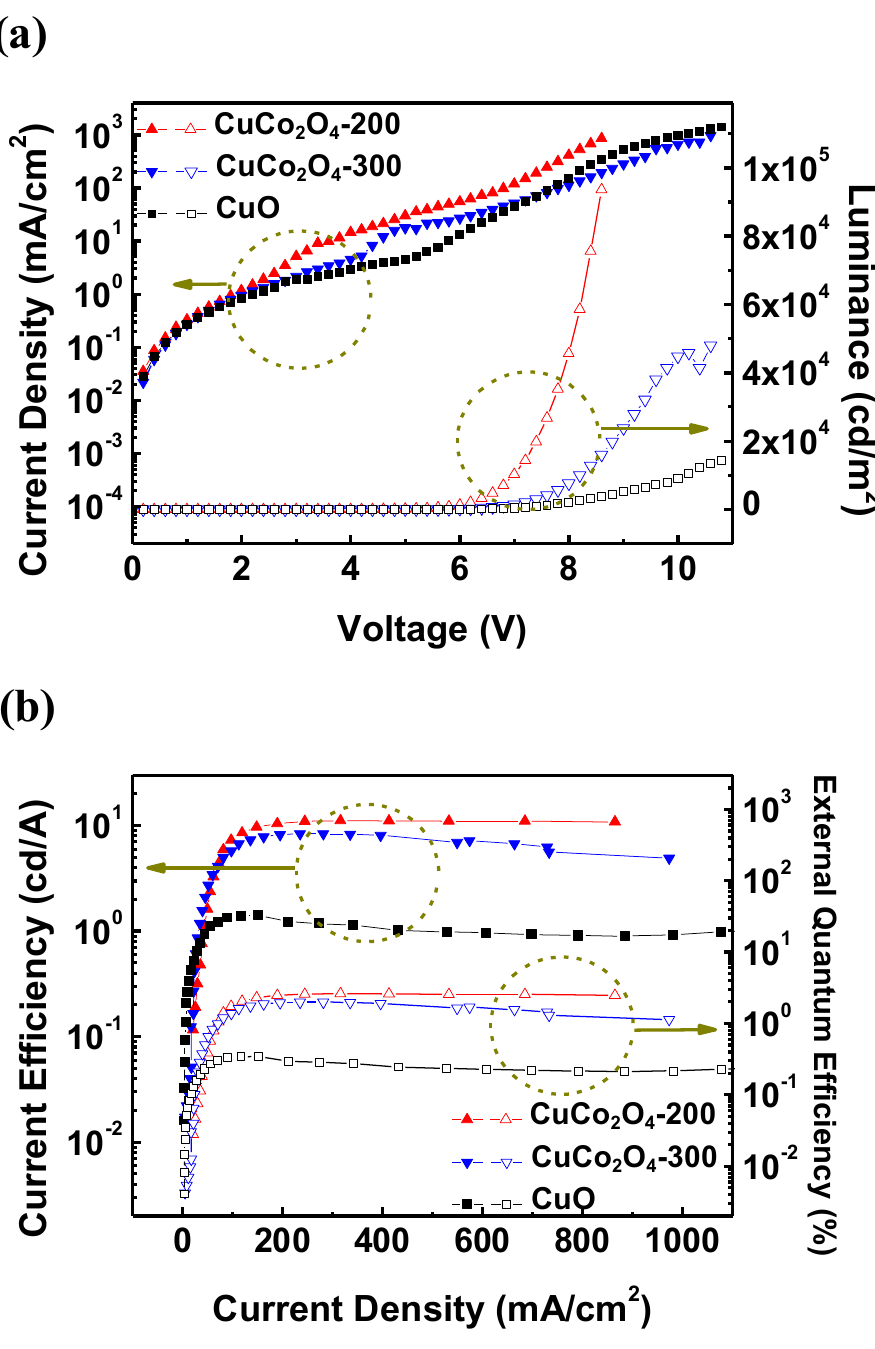
Figure 7. Performance of the QLEDs with CuCo 2 O 4 HILs. ( a ) Current density-voltage-luminance (J- Table 2. Summarized device performances of QLEDs at different CuCo 2 O 4 annealing temperature.